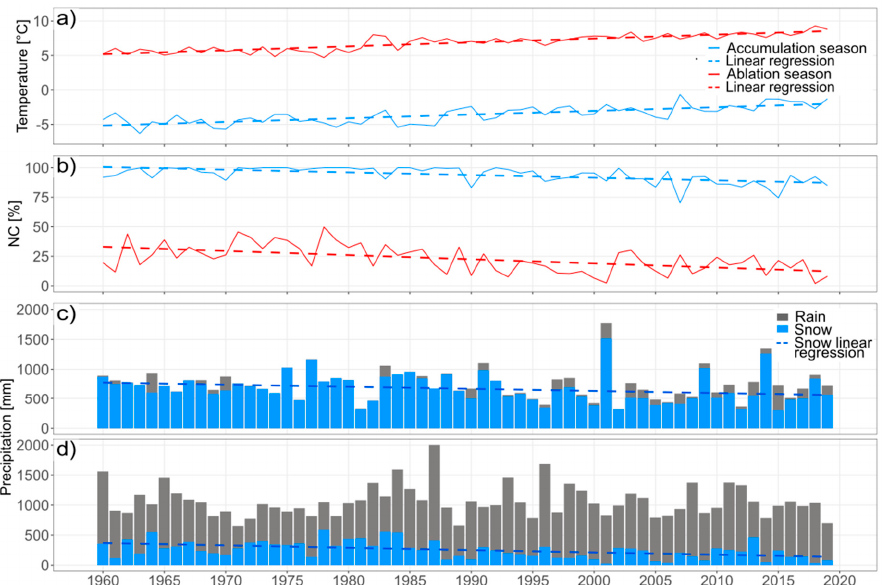
Figure 9. Time series of: ( a ) mean temperature of accumulation and ablation seasons extrapolated at the glacier’s mean elevation; ( b ) seasonal nivometric coefficient (NC) at the glacier’s mean elevation; total precipitation amount of ( c ) accumulation season, and ( d ) ablation season, fractioned into solid and liquid portions at the glacier’s mean elevation. Figure 10. Comparison of the 2010–2019 average monthly Nivometric Coefficient (NC) calculated at the glacier’s mean elevation with the 50-year average between 1960 and 2009. Table 4. Accumulation and ablation season temperature and precipitation in the 2010–2019 decade, compared to the 50-year means. Rain and snow fractions of total precipitation are also compared. Temperature is extrapolated at the mean elevation of the Montasio Glacier applying monthly-variable gradients to the Pontebba weather station data. Precipitation data from the same station are not extrapolated at the glacier’s elevation, but are partitioned into liquid and solid fractions using extrapolated temperature.